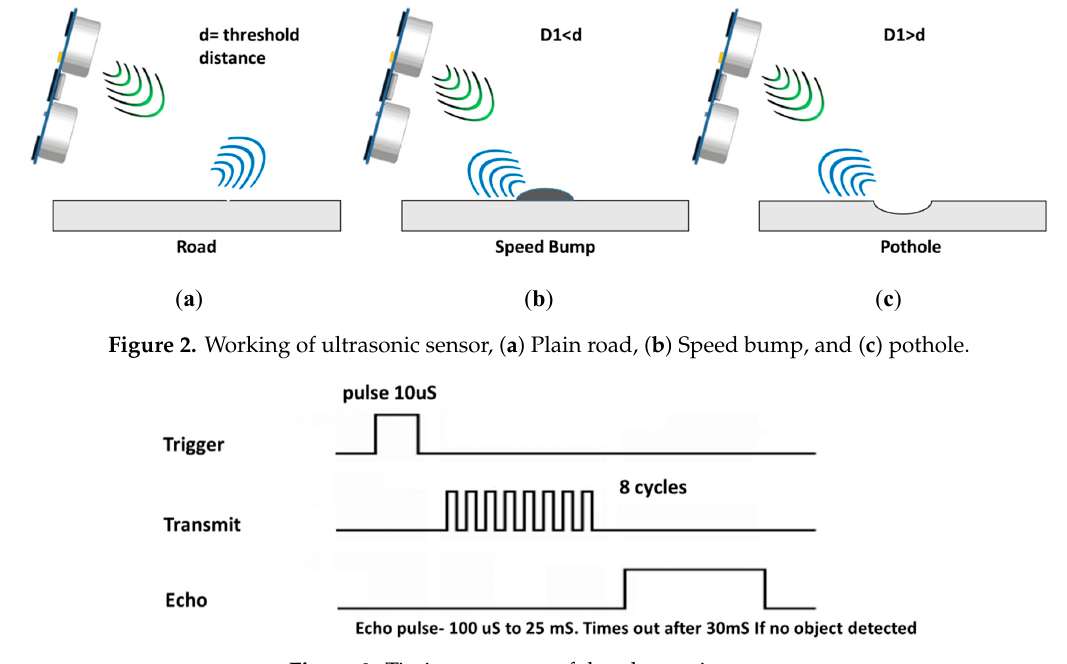
Figure 3. Timing response of the ultrasonic sensor.